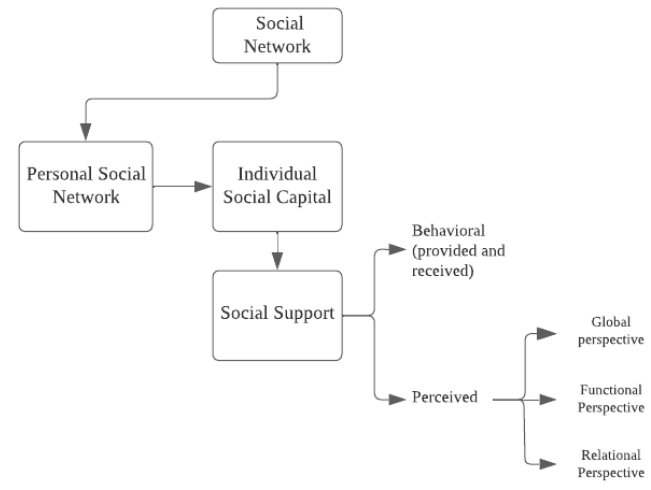
Figure 1. Theoretical Relationship Between the Targeted Variables.